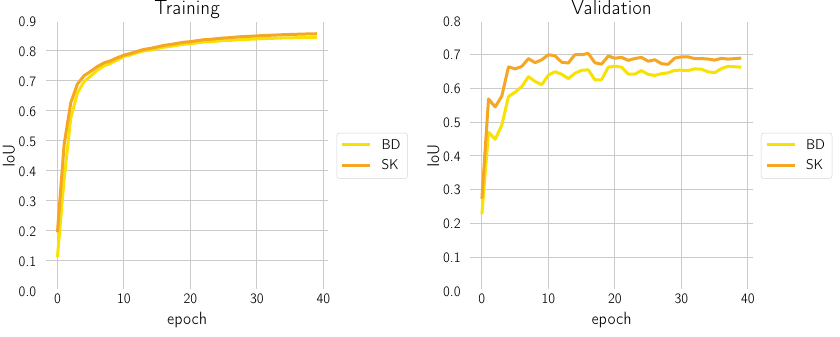
Figure 5. Evaluation of the IoU metric after every training epoch of the model on the training dataset ( left ) and the validation dataset ( right